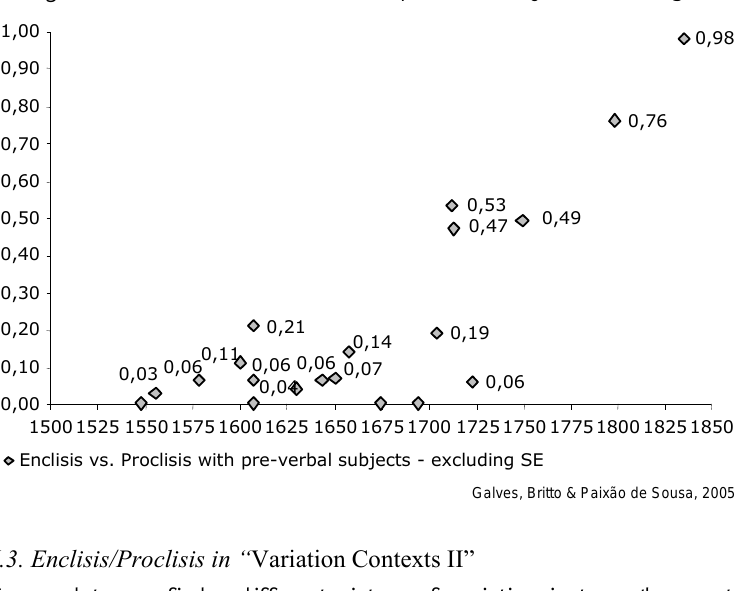
Figure 3 : Enclisis versus Proclisis with pre-verbal subjects – excluding clitic SE